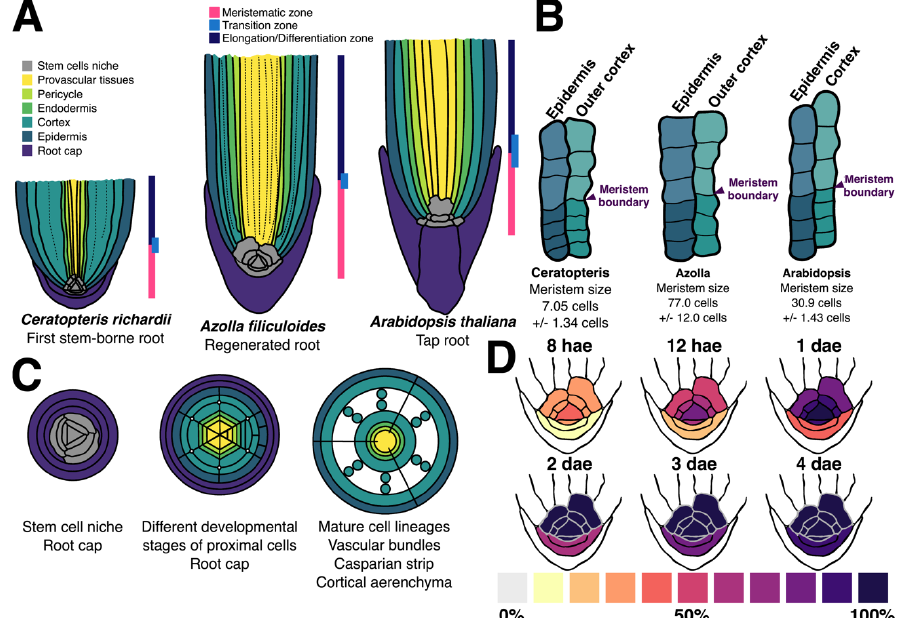
Figure 7. Graphic summary of the cellular organization and division dynamics in the